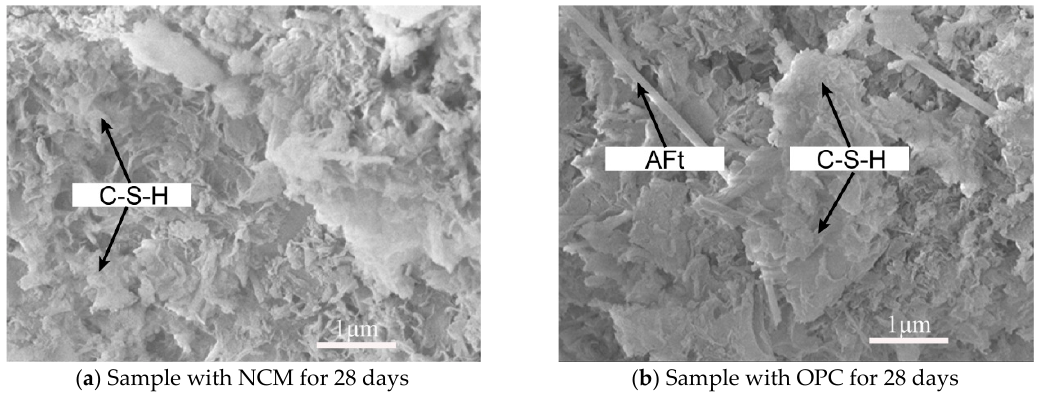
Figure 11. SEM images of samples with NCM and OPC for 7 days of curing time.